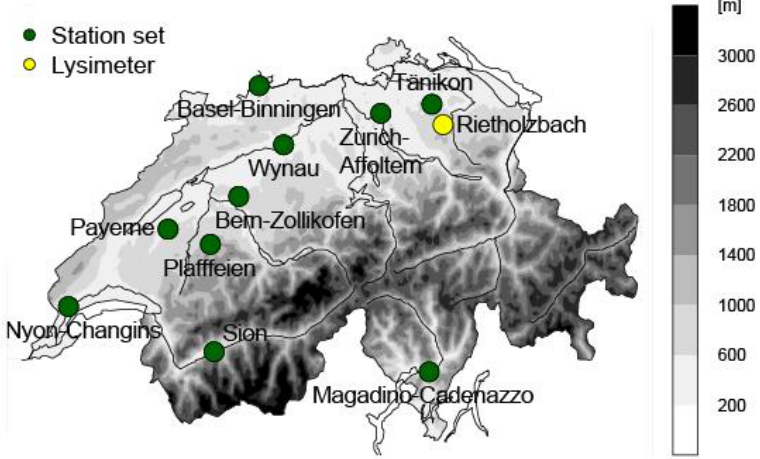
Figure 1. Location of the considered grassland station set ( green ) and the lysimeter station in Rietholzbach ( yellow ).